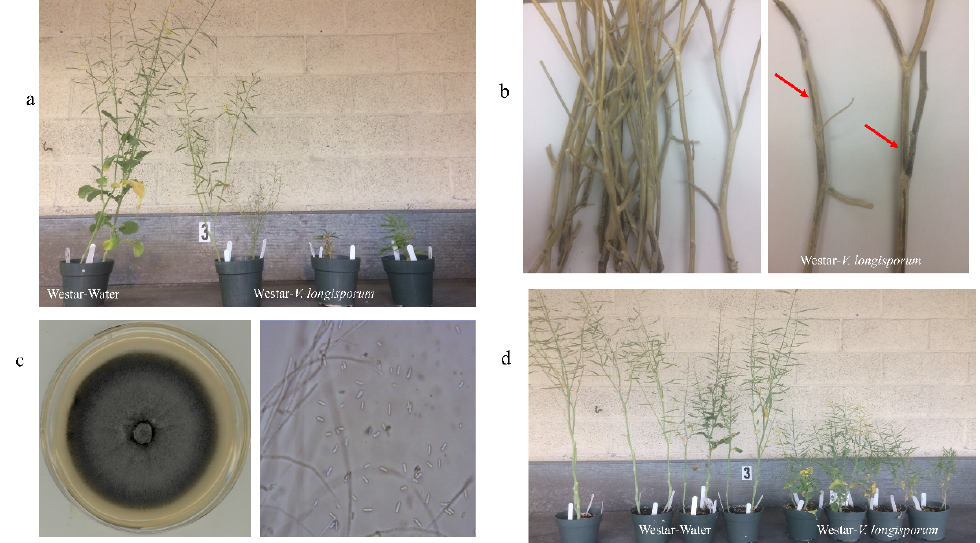
Figure 3. Pathogenicity test of Verticillium longisporum isolate (VL-H1) on canola susceptible cultivar ‘Westar’. Westar plants inoculated with water were included as controls. ( a ) Westar plants inoculated with V. longisporum isolate show a shorter height, stunting, leaf yellowing and senescence. ( b ) After harvest, the infected stems show black striping and microsclerotia. ( c ) Example of one V. longisporum isolate recovered from an infected canola stem. Isolate was grown on PDA plate, and conidia of isolate was observed under microscope. ( d ) Disease symptoms of Westar plants inoculated with recovered V. longisporum isolates. Westar plants inoculated with water were set as a non-disease control.